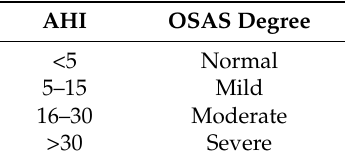
Table 1. Obstructive Sleep Apnea Syndrome Classification [8,9].